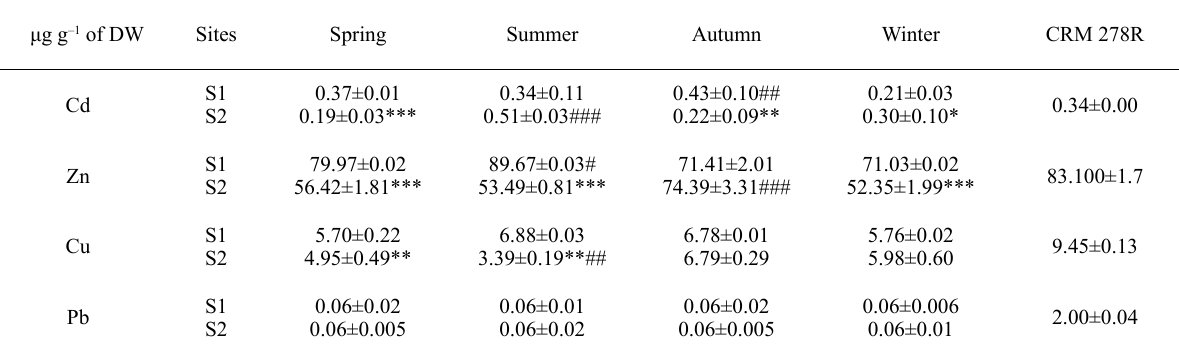
Table 2. – Seasonal variation of trace element concentrations (Cd, cadmium; Cu, copper; Pb, lead; Zn, zinc) in P. cultrifera tissues collected from S1 (the port of Rades) and S2 (the Punic port of Carthage).